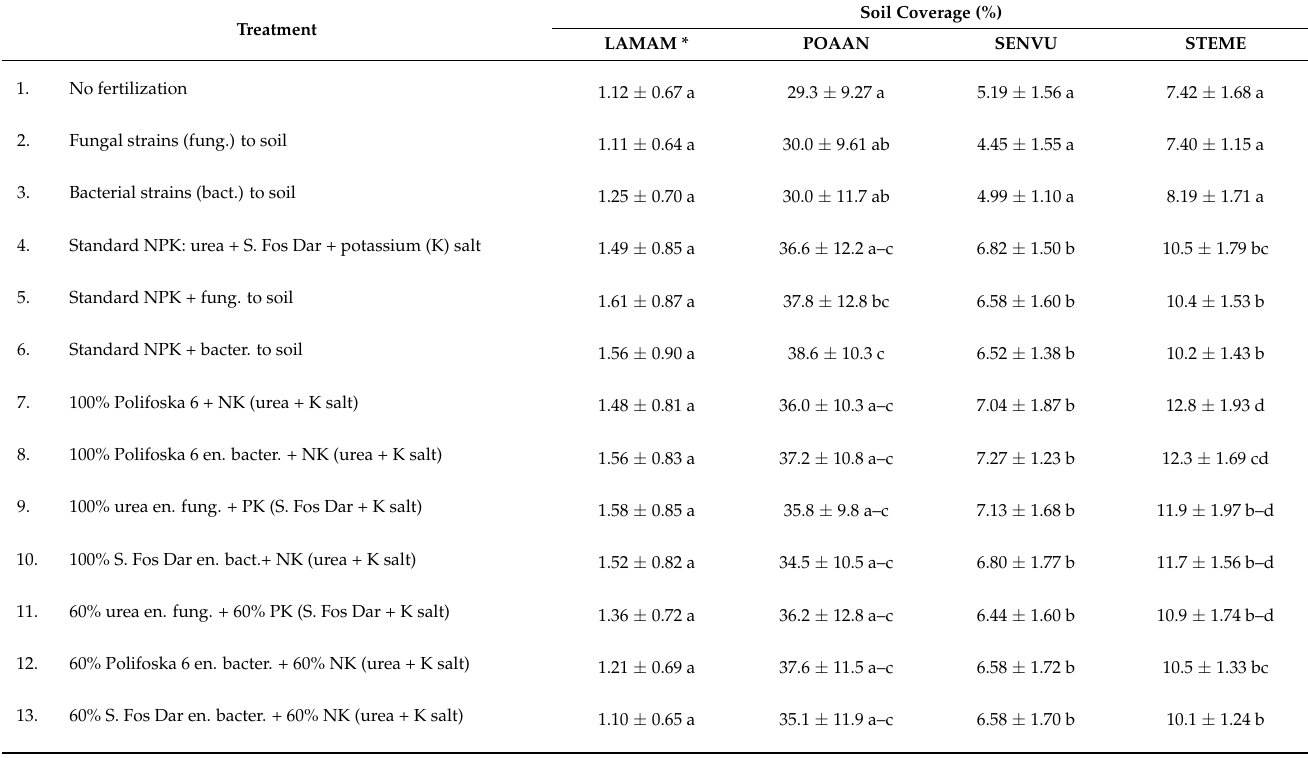
Table 3. Mean soil coverage with weeds in the apple orchard,